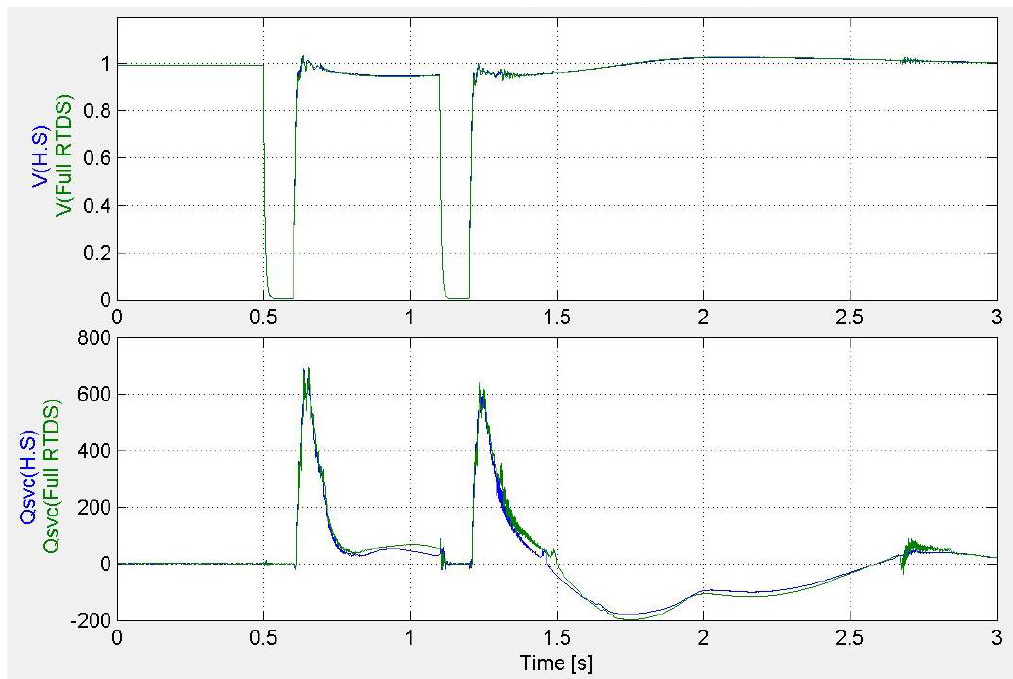
Figure 9. A 345 kV line fault is applied at Shin-Jecheon bus; Shin-Jecheon bus voltage (first row) and reactive power of SVC (second row); RTHS (blue line) and large-scale RTS (green line).